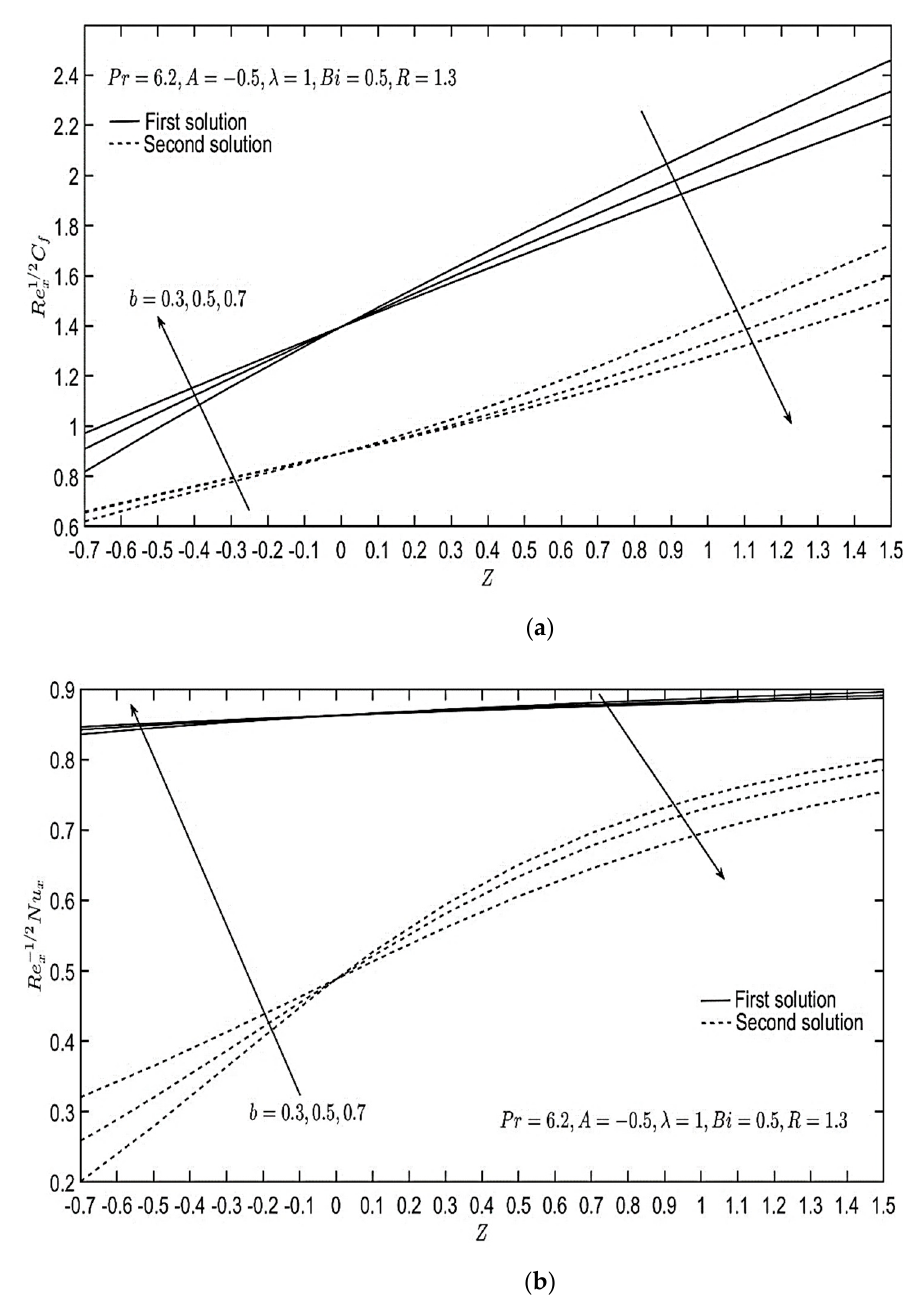
Figure 4. Plots of ( a ) Re 1/2 x C f and ( b ) Re − 1/2 x Nu x with various values of b and Z